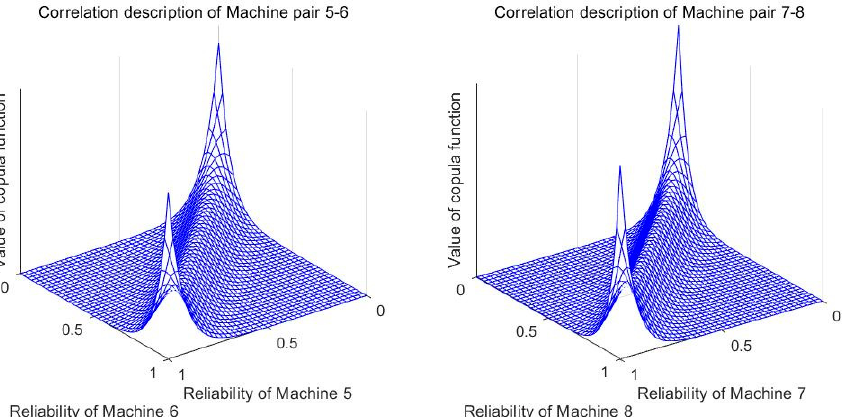
Figure 7. Images of Frank copula functions with optimized parameters for Machine pair 5–6 and Machine pair 7–8. Machine pair